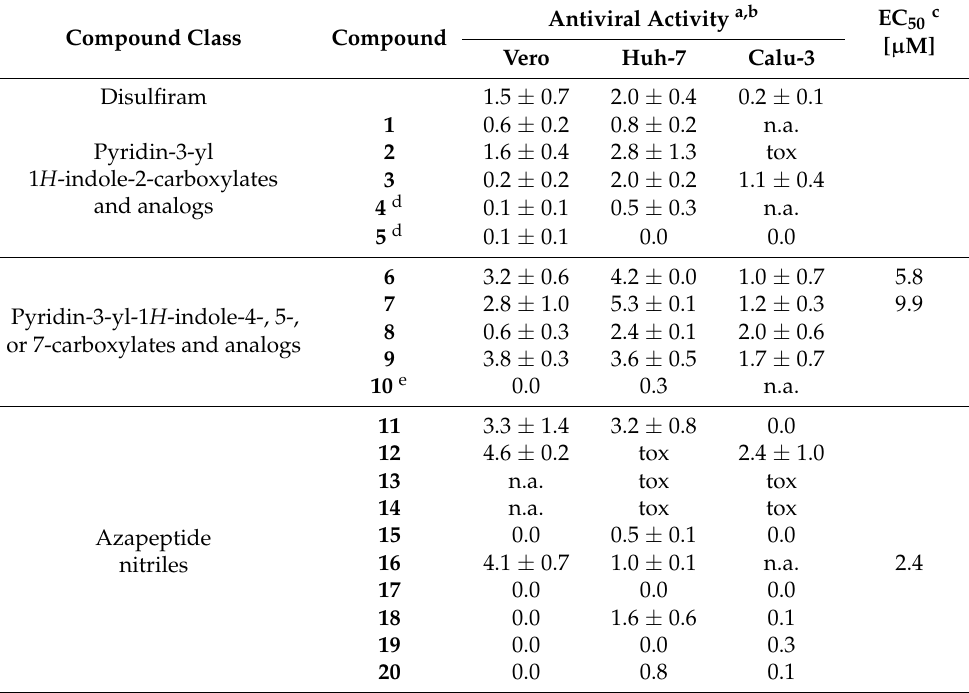
Table 1. Inhibition of SARS-CoV-2 dependent on the infected cell